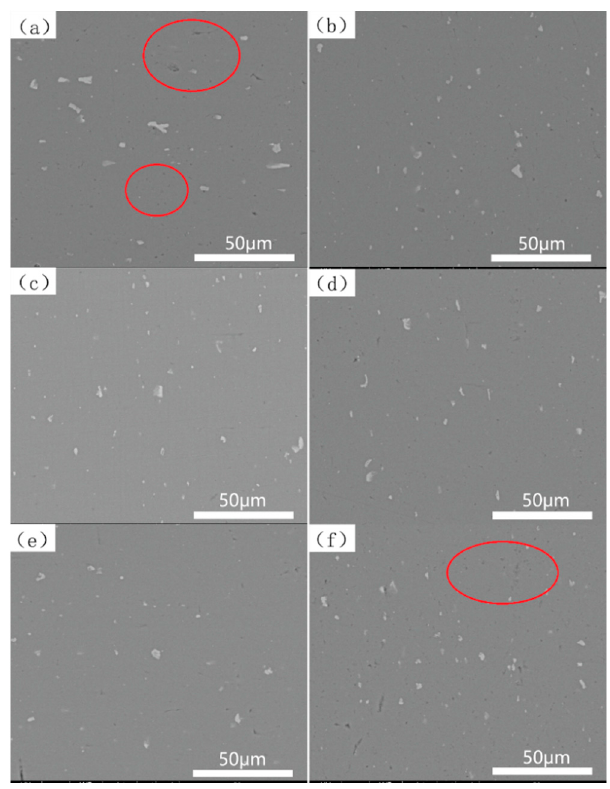
Figure 10. SEM micrographs of delayed aging specimens. ( a ) 1 h; ( b ) 8 h; ( c ) 12 h; ( d ) 20h; ( e ) 24 h; ( f ) 48 h.